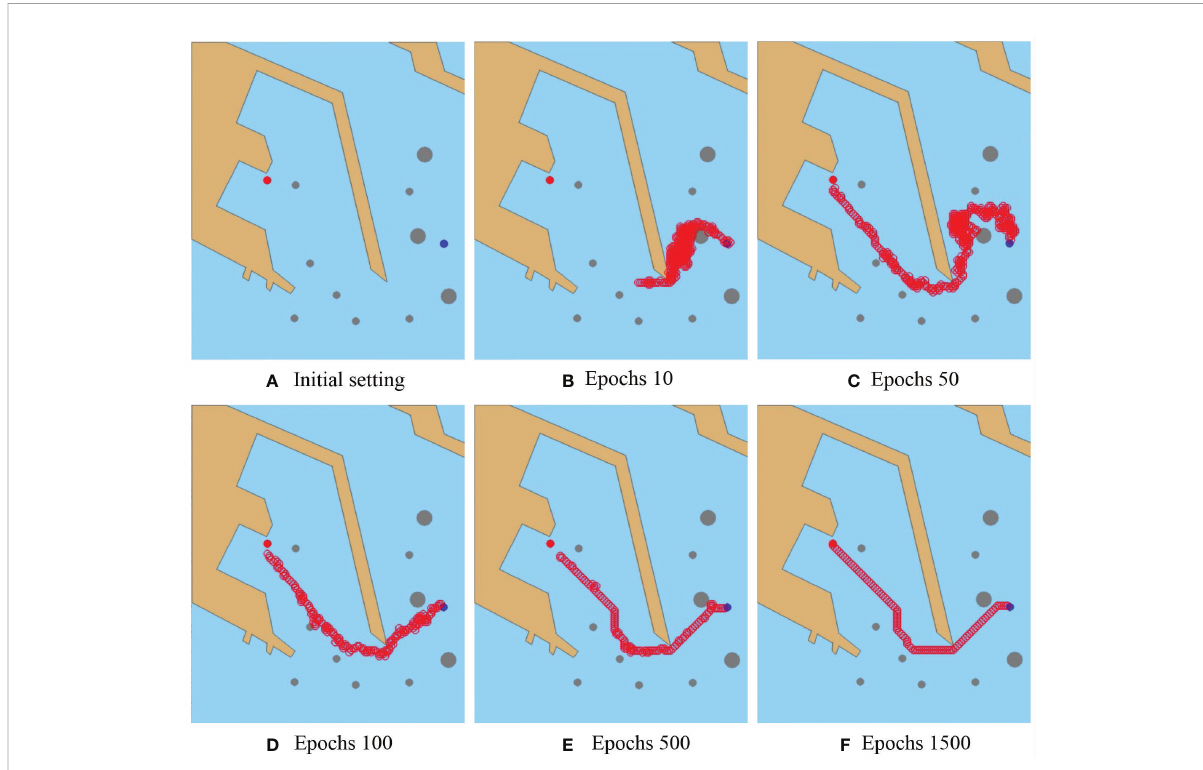
FIGURE 6 Result of collision avoidance in the coastal static environment. Snapshots of the six epochs in simulation: (A) initial setting, (B) epochs 10, (C) epochs 50, (D) epochs 100, (E) epochs 500, and (F) epochs 1500. The red hollow circle is the collision avoidance path of the MASS. A safety area of 5 pixels is set for the MASS to be away from all the obstacles. In the training scenario, the MASS ’ s goal is to sail from the start point to the goal point safe.